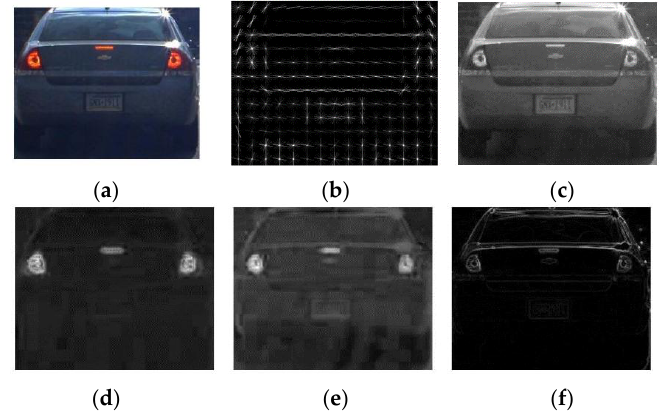
Figure 11. ACF channels for the image ( a ): ( b ) is HOG; ( c ) is L color space in LUV; ( d ) is U color space in LUV; ( e ) is V color space in LUV; ( f ) is normalized edge.